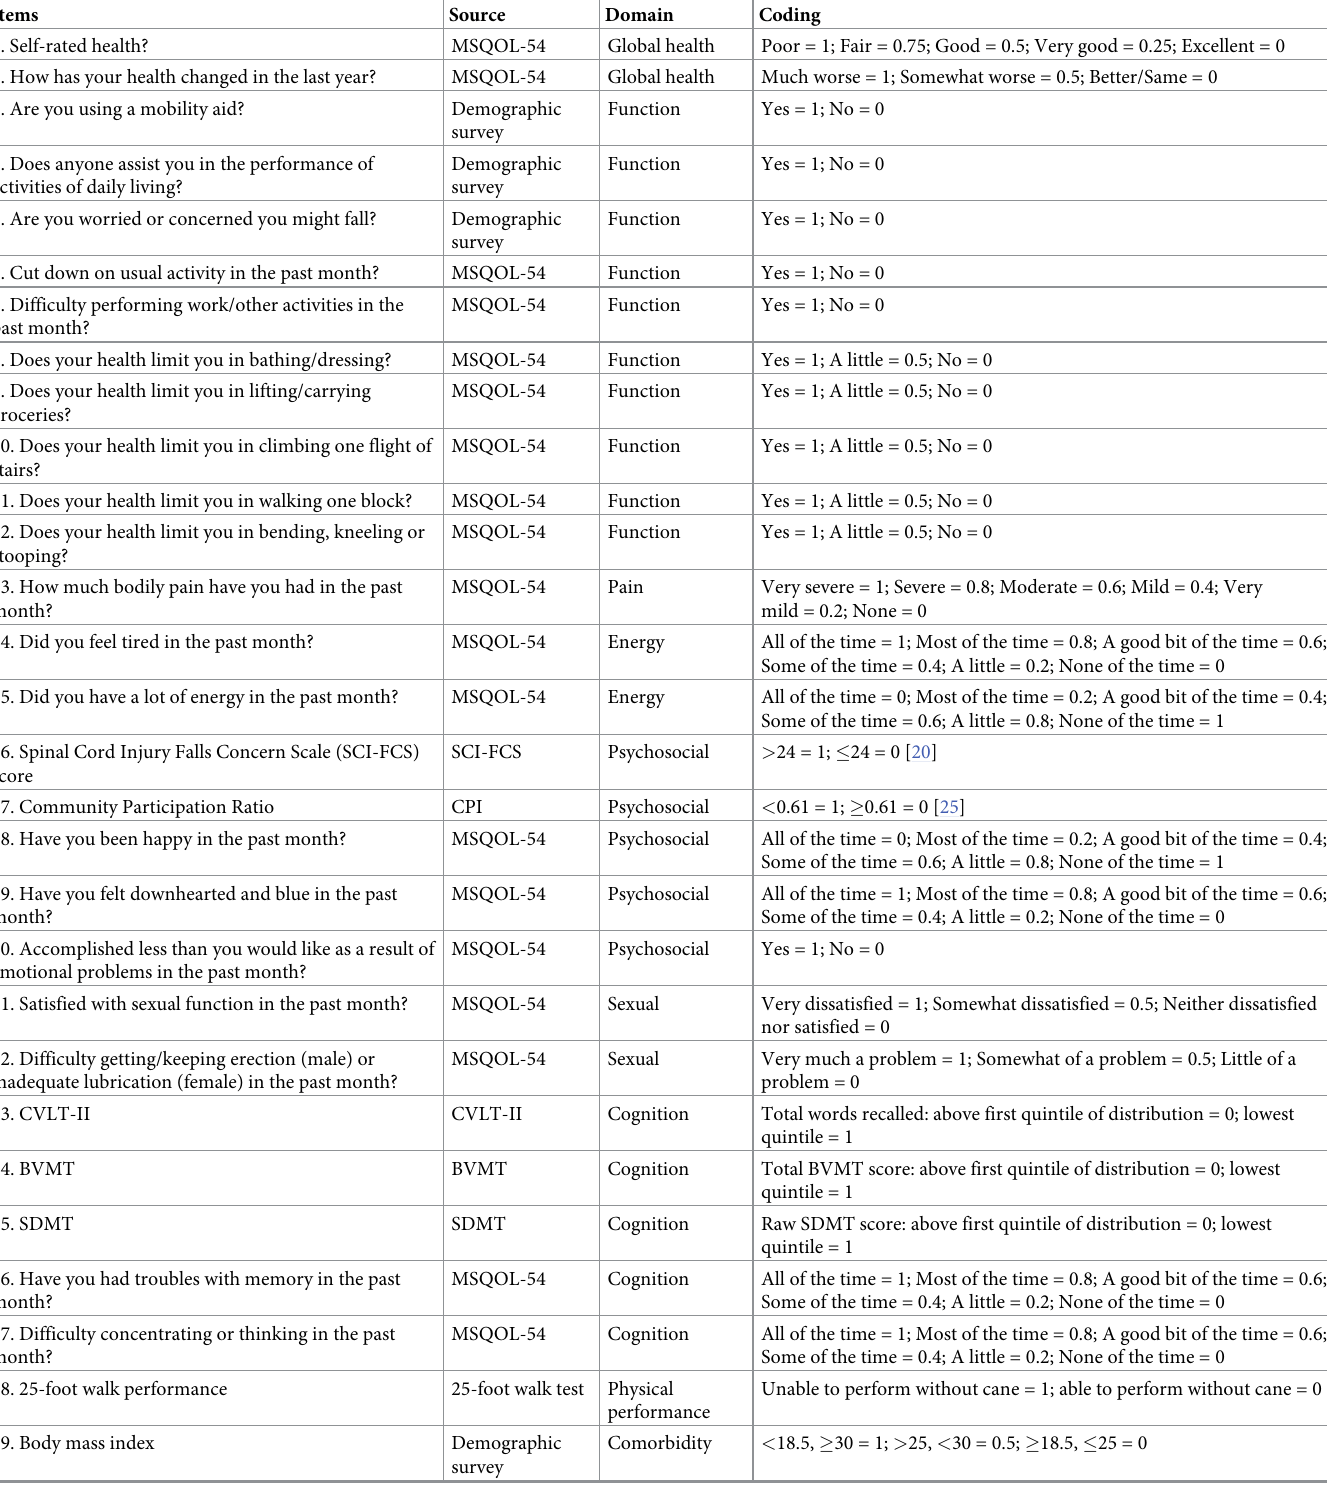
Table 1. Operational definition of frailty index: List of deficits included as variables.